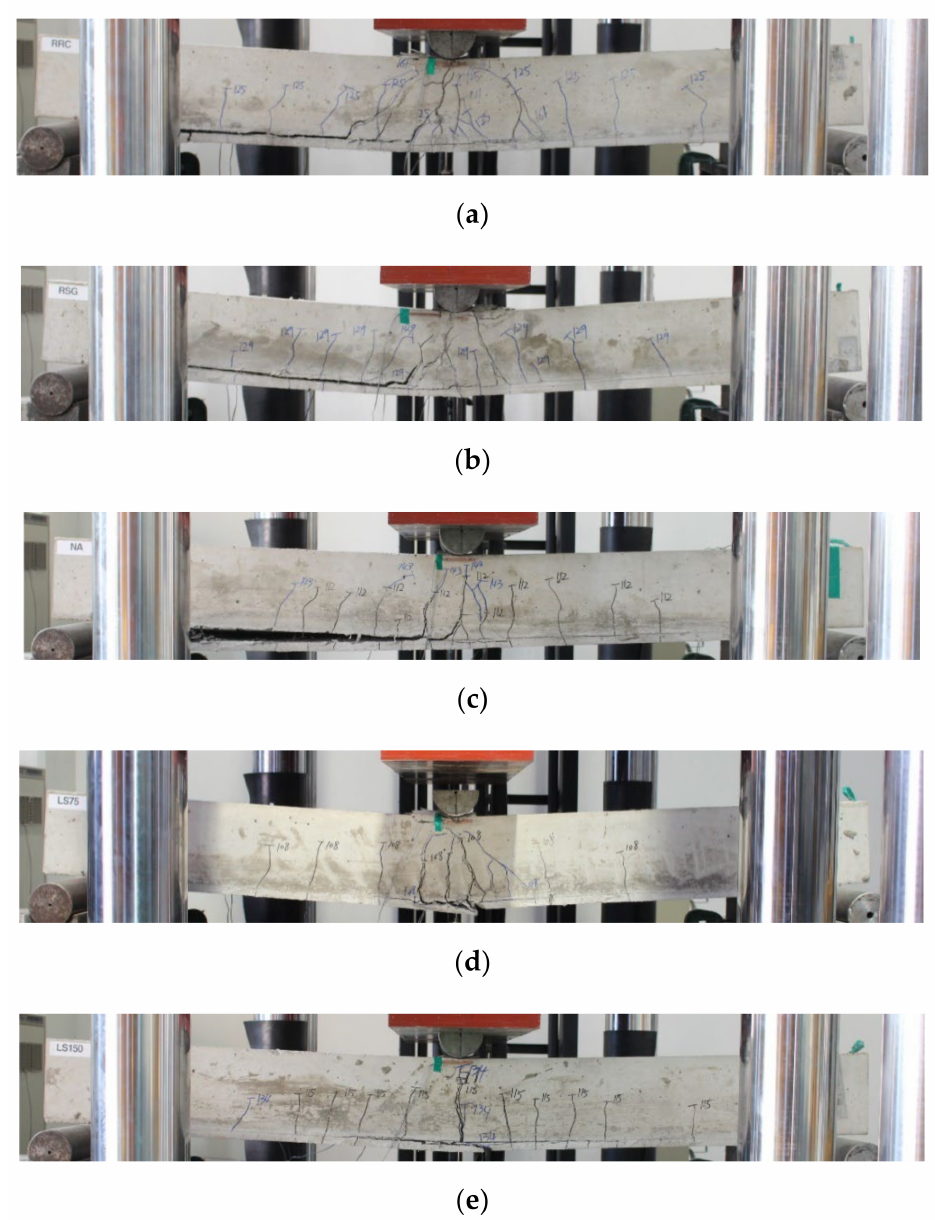
Figure 17. Failure patterns of specimens: ( a ) RRC, ( b ) RSG, ( c ) NA, ( d ) LS75; ( e )